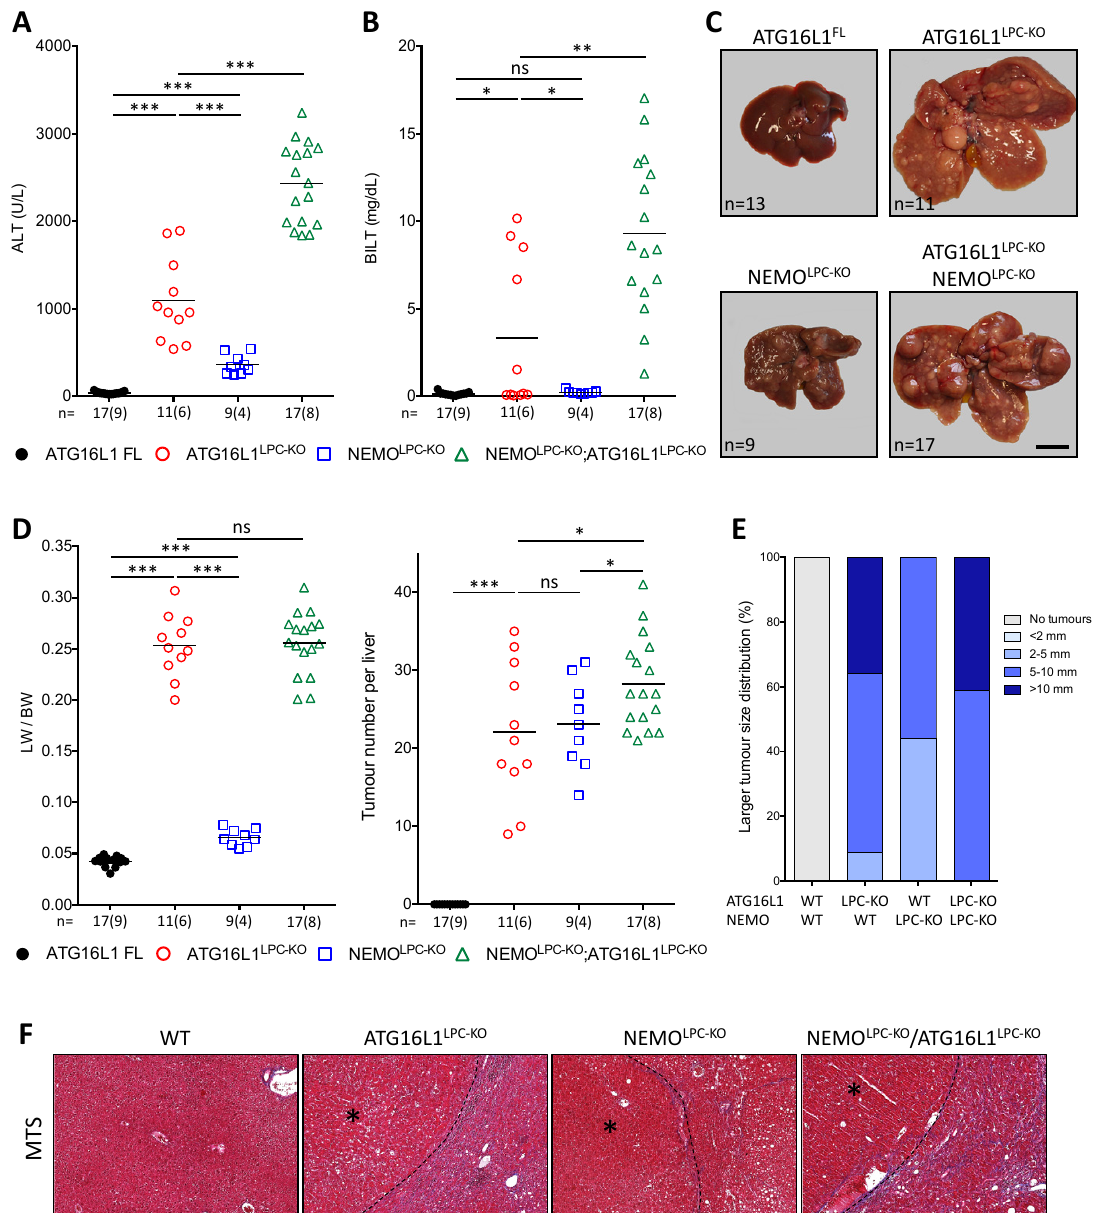
Figure 3. Combined NEMO deficiency and autophagy inhibition leads to aggravated CLD and hepatocarcinogenesis. ( A , B ) Serum ALT ( A ) and total bilirubin ( B ) levels in 40–52-week-old mice with the indicated genotypes. Each symbol represents one mouse and horizontal lines indicate mean values. ( C ) Representative liver images from 52-week-old mice with the indicated genotypes. ( D , E ) Tumor load in mice with the indicated phenotypes as estimated by quantification of the LW/BW ratio and tumor number per liver ( D ), and the larger tumor size distribution ( E ). Each symbol represents one mouse and horizontal lines indicate mean values. ( F ) Representative images of Masson’s trichrome stained (MTS) liver sections from 40–52-week-old mice with the indicated genotypes. HCC/dysplastic nodule areas are marked with an asterisk. In ( A , B , D ), n indicates the number of analyzed mice, out of which the number of males is shown in brackets. ns, not significant; * p ≤ 0.05, ** p ≤ 0.01, *** p ≤ 0.005. Bars: ( C ) 1 cm; ( F ) 200 µ